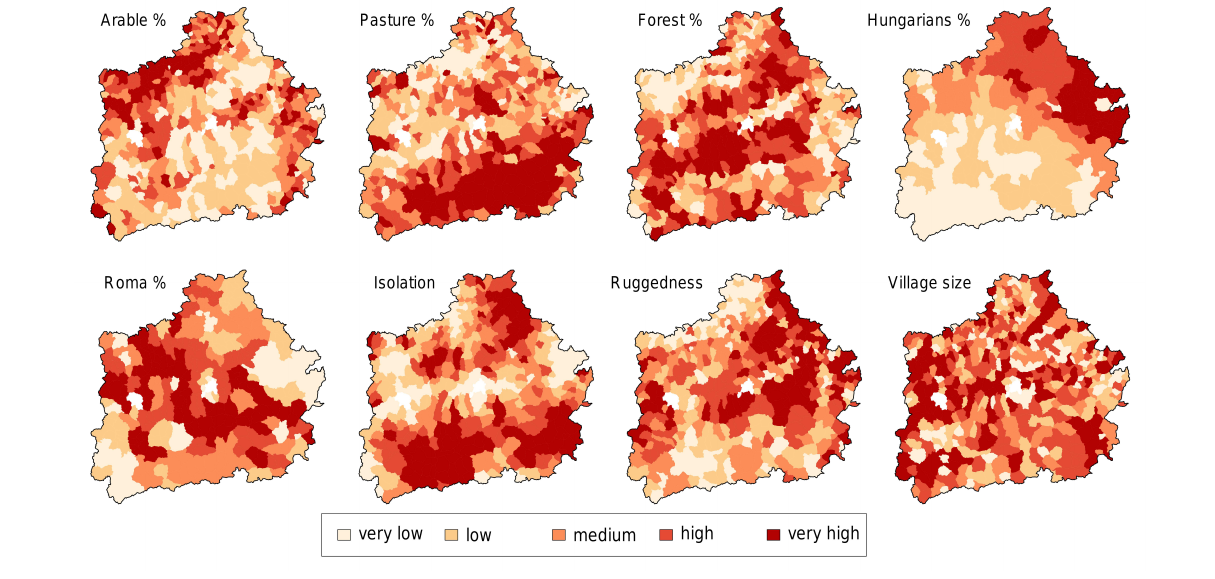
Fig. 4. Maps describing local conditions in the village catchments with respect to selected variables. The classes “very low” to “very high” correspond to quintiles of the raw data.